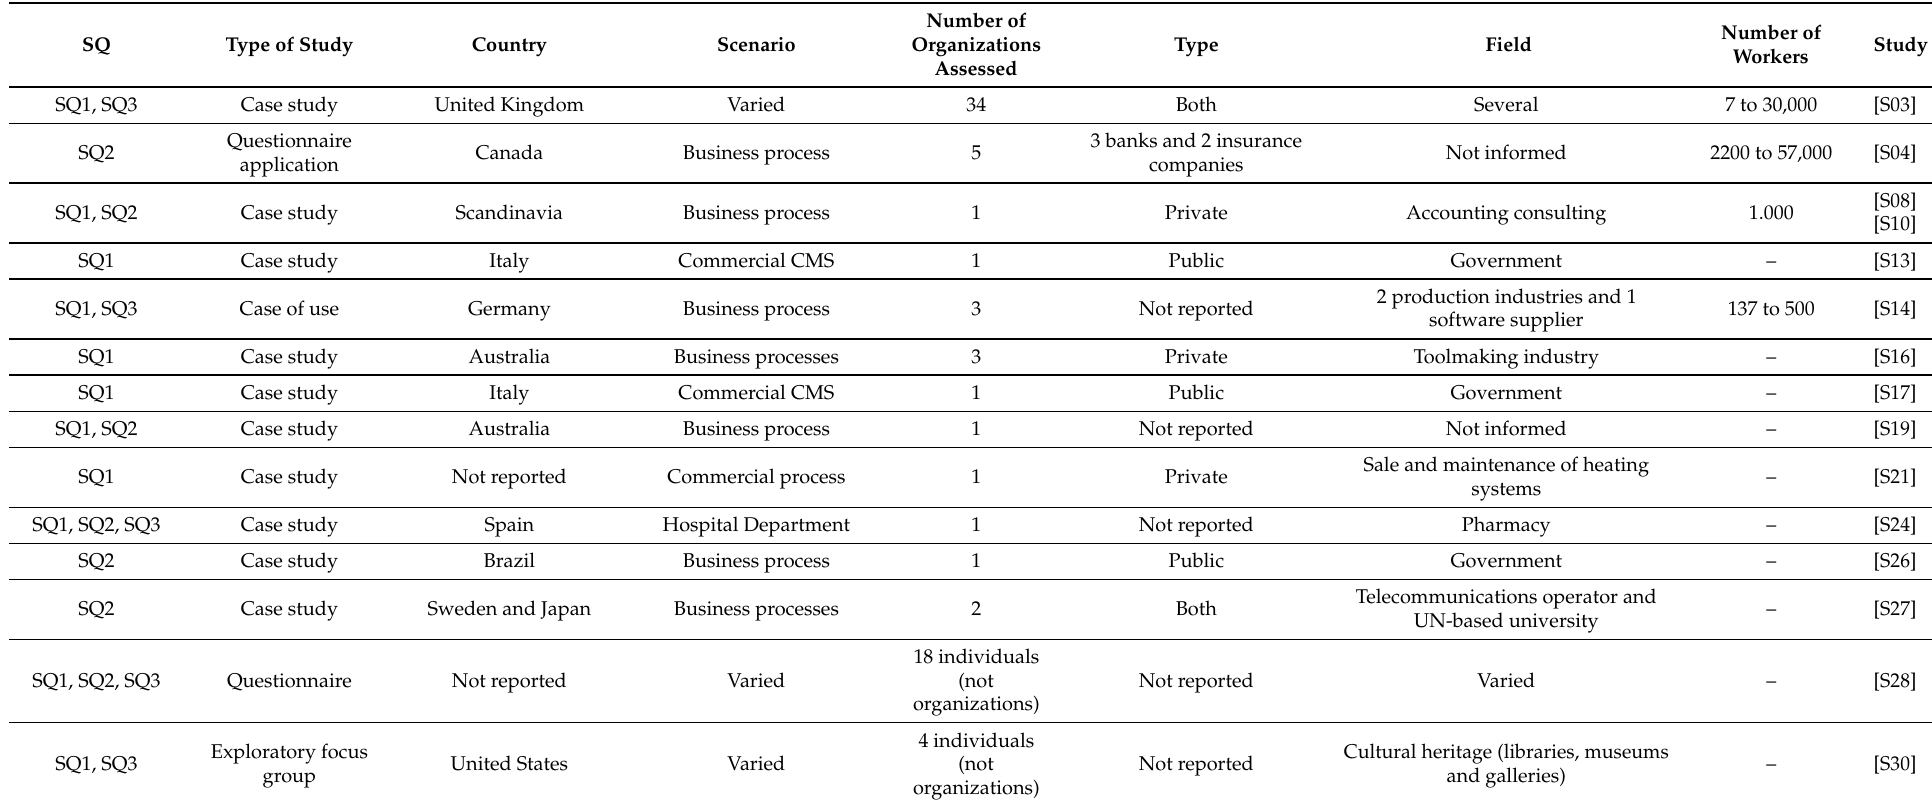
Table 8. Papers that respond to